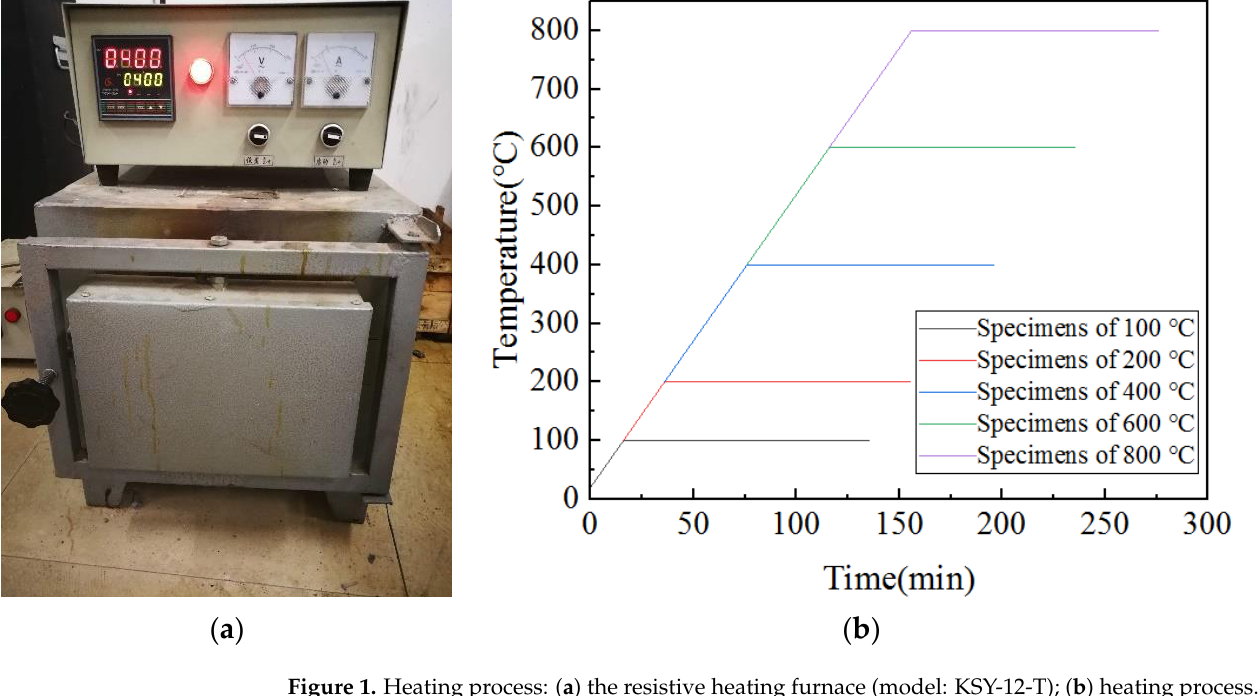
Figure 1. Heating process: ( a ) the resistive heating furnace (model: KSY-12-T); ( b ) heating process.